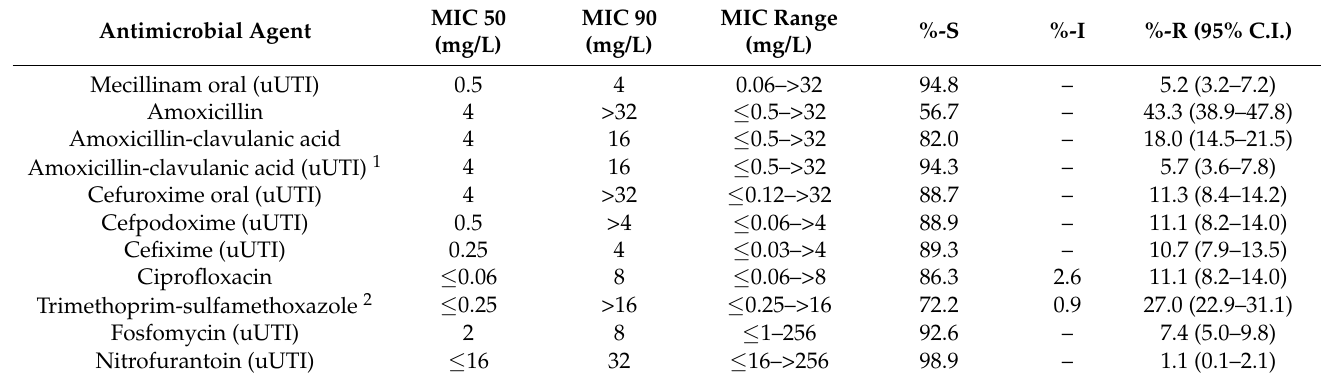
Table 1. In vitro activity of mecillinam and nine comparator agents against 460 E. coli urine isolates.